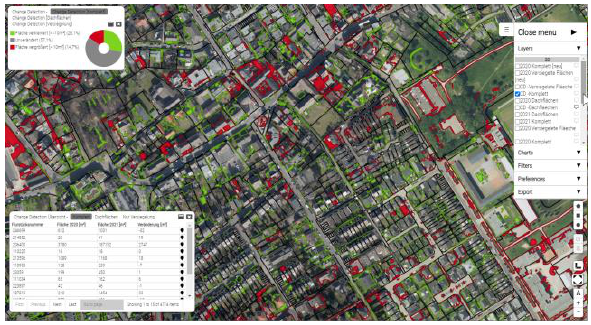
Figure 14: Hexagon M.App Enterprise to derive and visualize changes in impervious areas based on hybrid sensor data and GeoAI analysis.